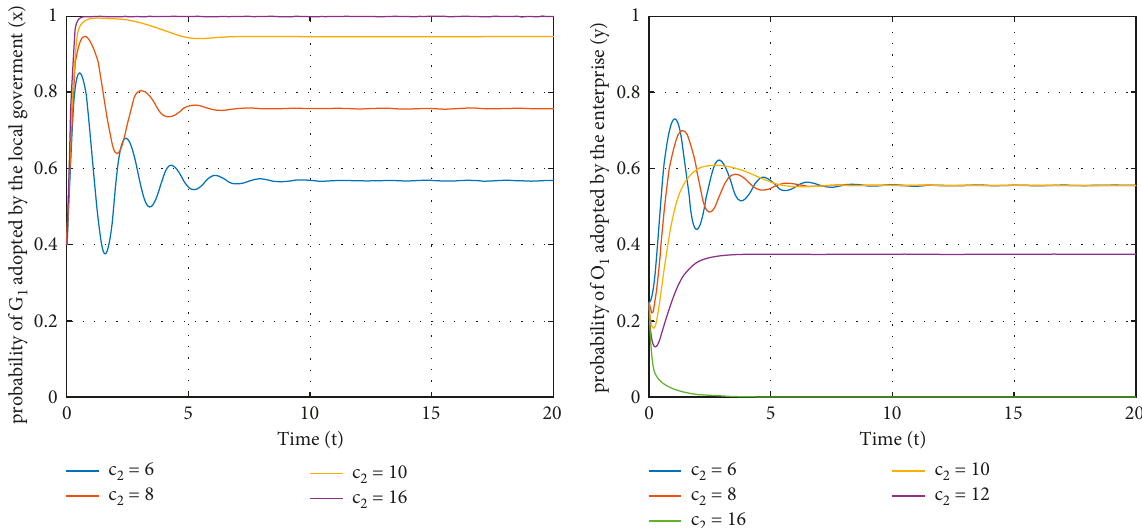
Figure 9: The impact of raising the upper limit of c